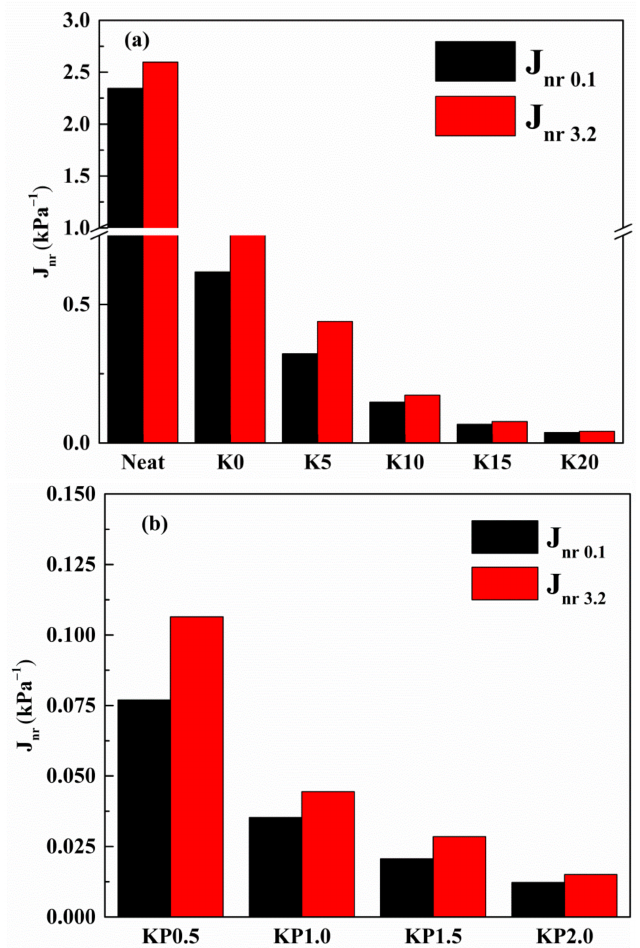
Figure 7. Average Jnr of tested samples under 0.1 kPa and 3.2 kPa at 60 ◦ C: ( a ) SBS/OSDOA-modified asphalts; ( b ) composite modified